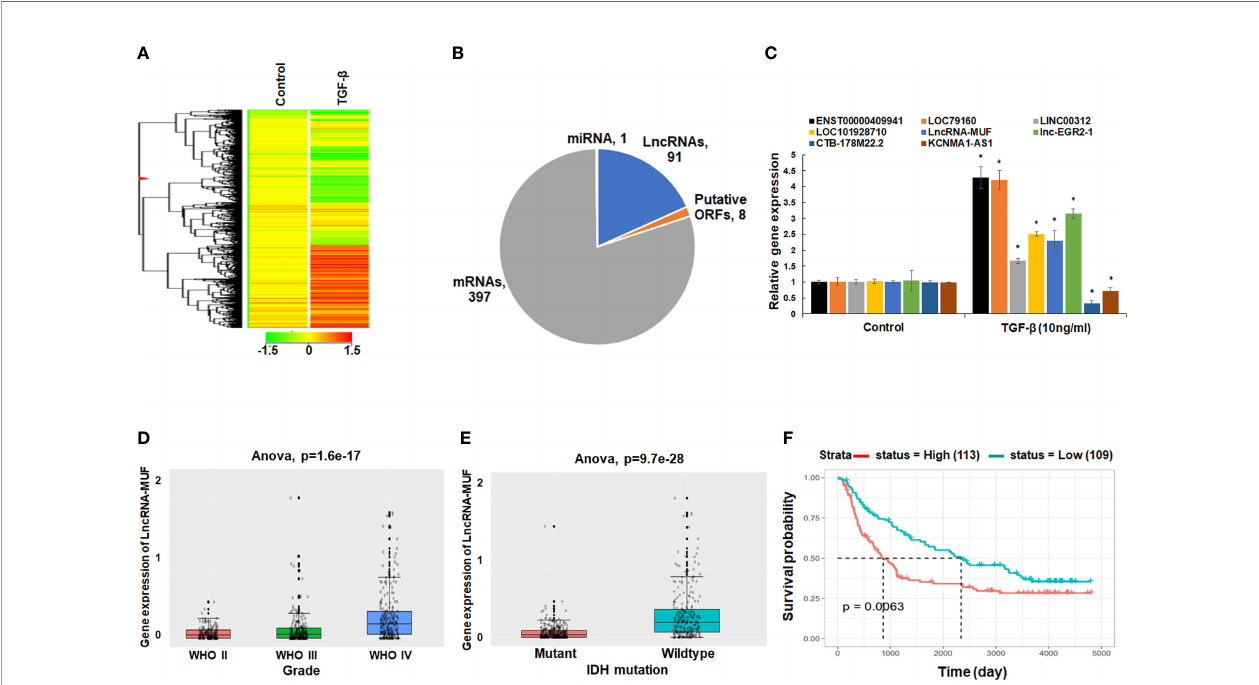
FIGURE 1 | LncRNA-MUF is overexpressed in GBM, and it is induced by TGF- b . (A) Heatmap representing the relative abundance of differentially expressed genes (DEGs, ≥ 1.5-fold, p < 0.05) in T98G cells upon TGF- b 1 (10 ng/ml) treatment for 24 h. (B) Pie chart representing the class of DEGs (p < 0.05) identi fi ed from genome- wide microarray screening in T98G GBM cells upon TGF- b 1 treatment for 24 h. (C) Validation of top TGF- b -regulated lncRNAs identi fi ed from microarray screening using qRT-PCR in T98G cells. RNA samples were analyzed by qRT-PCR, and error bars represent the mean ± SEM from three independent experiments. *Signi fi cant change in TGF- b -treated cells compared to control cells (p < 0.05). (D) LncRNA-MUF expression analysis in glioma tissues from the CGGA database. Elevated expression of MUF in GBM IV compared to lower-grade gliomas (p=1.6e- 17 ). (E) LncRNA-MUF levels are elevated in IDH wild-type GBM patients compared to IDH mutant cases as analyzed from the CGGA database (ANOVA, p = 9.7e- 28 ). (F) Kaplan – Meier survival analysis of lncRNA-MUF expression in glioma samples from CGGA databases shows that a high lncRNA-MUF expression is associated with poor overall survival in primary and recurrent GBM patients (p = 0.0063). Red line represents high lncRNA-MUF expression group, and green line represents the low lncRNA-MUF expression